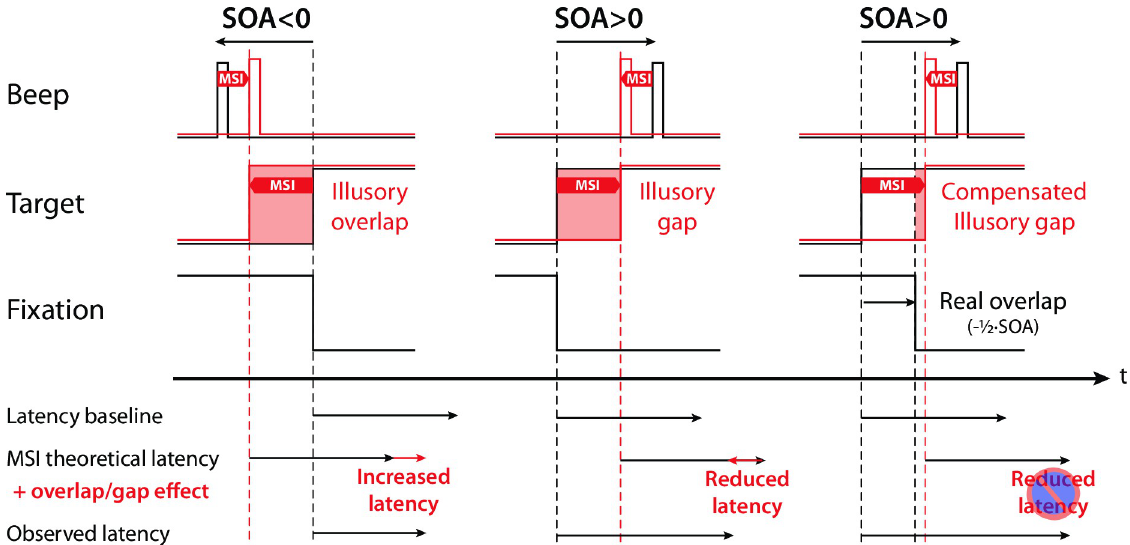
Fig 1. Illusory gap/overlap in the construction of saccade latencies. Illustration of how multisensory integration (MSI) could introduce an illusory overlap/gap for negative/positive SOAs, by binding temporally the target onset with the beep signal (left/middle panel). This shift in time of the perceived target onset would produce an MSI theoretical latency that also shifts. However, the illusory overlap/gap would also produce an increase/decrease of saccade latencies that would go against the MSI theoretical effect and reduce the observed latency modulation. The right panel illustrates how adding a real overlap, arbitrarily set to half of the SOA, could compensate for the illusory gap introduced by the MSI for positive SOAs and thereby allowing a larger expression of the MSI modulation in the observed saccade latency.